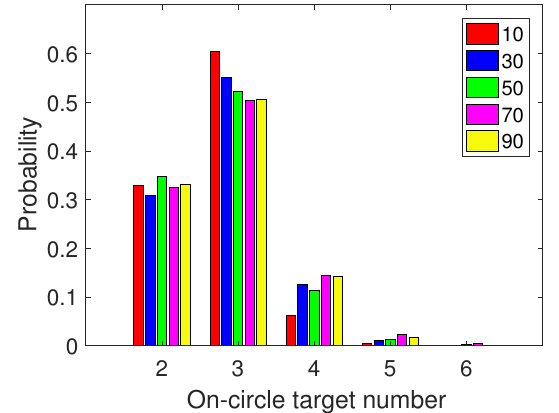
Figure 4. The probability of the on-circle target